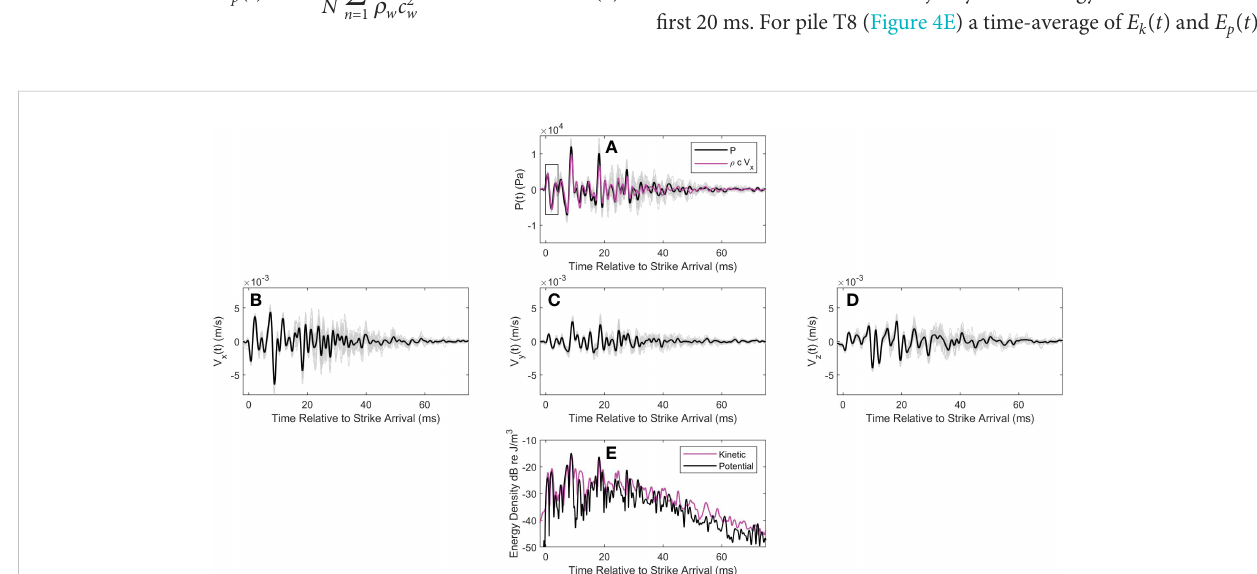
FIGURE 5 (A) coherent average of pressure over N strikes (cid:1) p ( t ) (black line) and individual strike time series p n ( t ) (gray lines). Measurements are from pile T5 at range 16 m. Magenta line shows coherent average of the x -component of acoustic velocity (cid:1) v x ( t ) scaled by r w c w . For this display the sign of (cid:1) v x ( t ) is fl ipped. Data shown within the box (duration 4-ms) are used in subsequent analysis. (B) Coherent average of (cid:1) v x ( t ) along with individual strike time ( t ) (gray lines); (C, D) provide similar display of (cid:1) v y ( t ) and (cid:1) v z ( t ), respectively, together with the individual strike time series (gray lines). (E) Time series v x n varying potential (black line) and kinetic (magenta line) energy density averaged over N